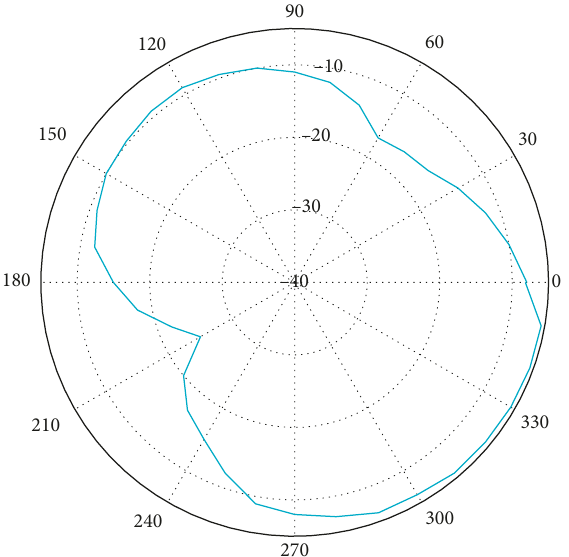
Figure 12: Emission diagram in horizontal polarization in the 1 st plane (dbm).